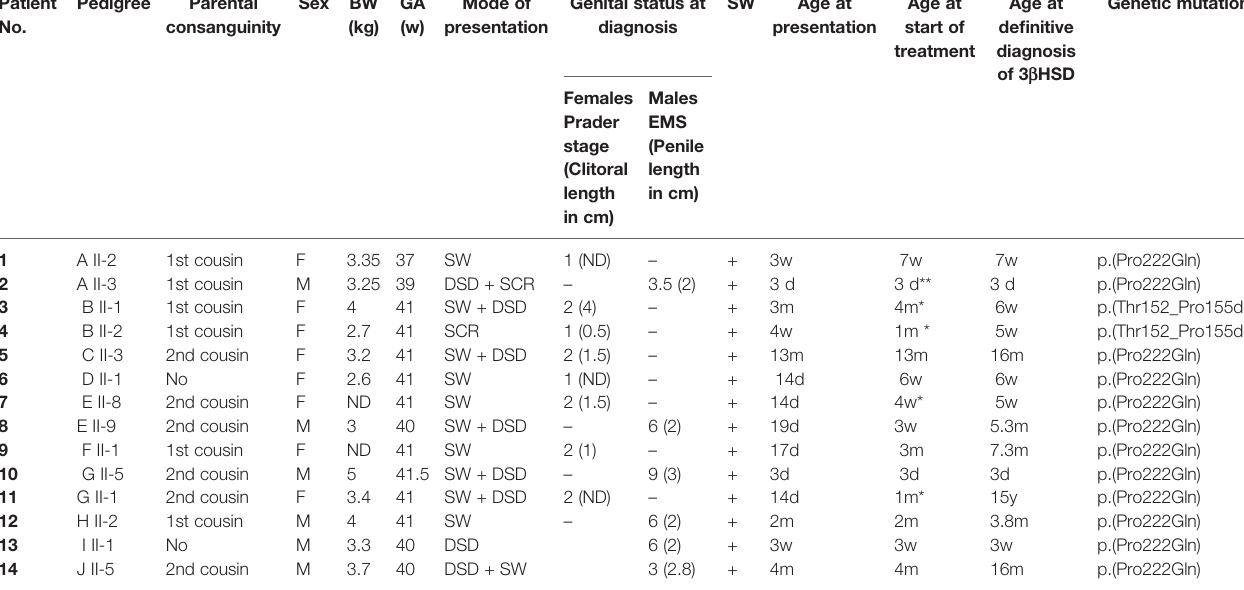
TABLE 1 | Clinical data and features at fi rst examination for 14 Algerian patients from 10 families with con fi rmed 3 b -hydroxysteroid dehydrogenase (3 b HSD) de fi ciency. Patient